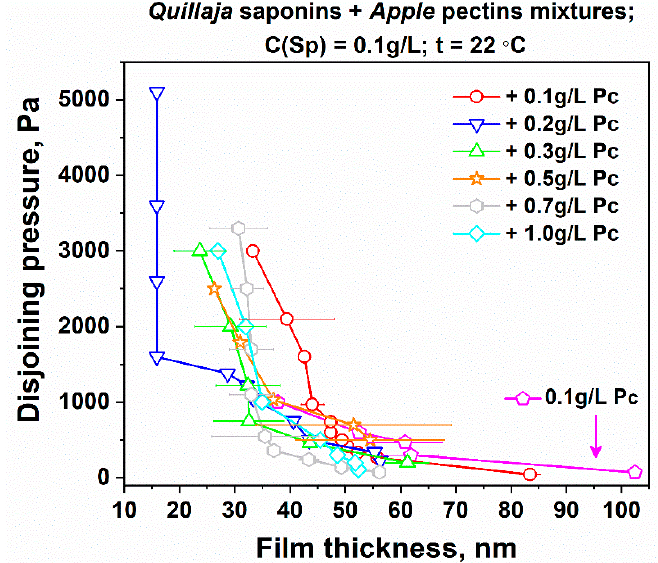
Figure 8. Disjoining pressure vs. film thickness isotherms of foam films from Quillaja saponin solution at C(Sp) = 0.1 g/L and its mixtures with various Apple pectin quantities. The isotherm for the Apple pectin-only solution at C(Pc) = 0.1 g/L is also presented. Table 2. Critical pressure of rupture of foam films from aqueous solutions of saponin-only, pectin- only and saponin/pectin mixtures, obtained using porous plate in TLF-PBT.